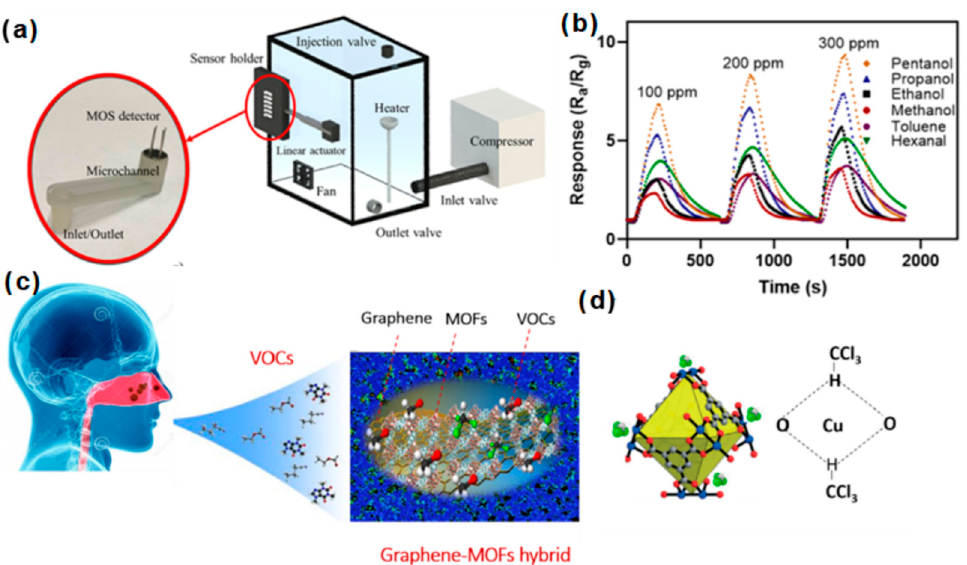
Figure 9. ( a ) Schematic illustration of the microfluidic gas sensor; ( b ) the sensing intensity of the microfluidic gas sensor for different VOCs [87]. Copyright (2022), used with permission from the American Chemical Society. ( c ) Response of graphene and MOF hybrid nanocomposite on exhaled gas; ( d ) the schematic diagram of the hydrogen bond affinity between copper benzene–1,3,5–tricarboxylate (Cu–BTC) and chloroform molecules [93]. Copyright (2020), used with permission from the American Chemical Society.